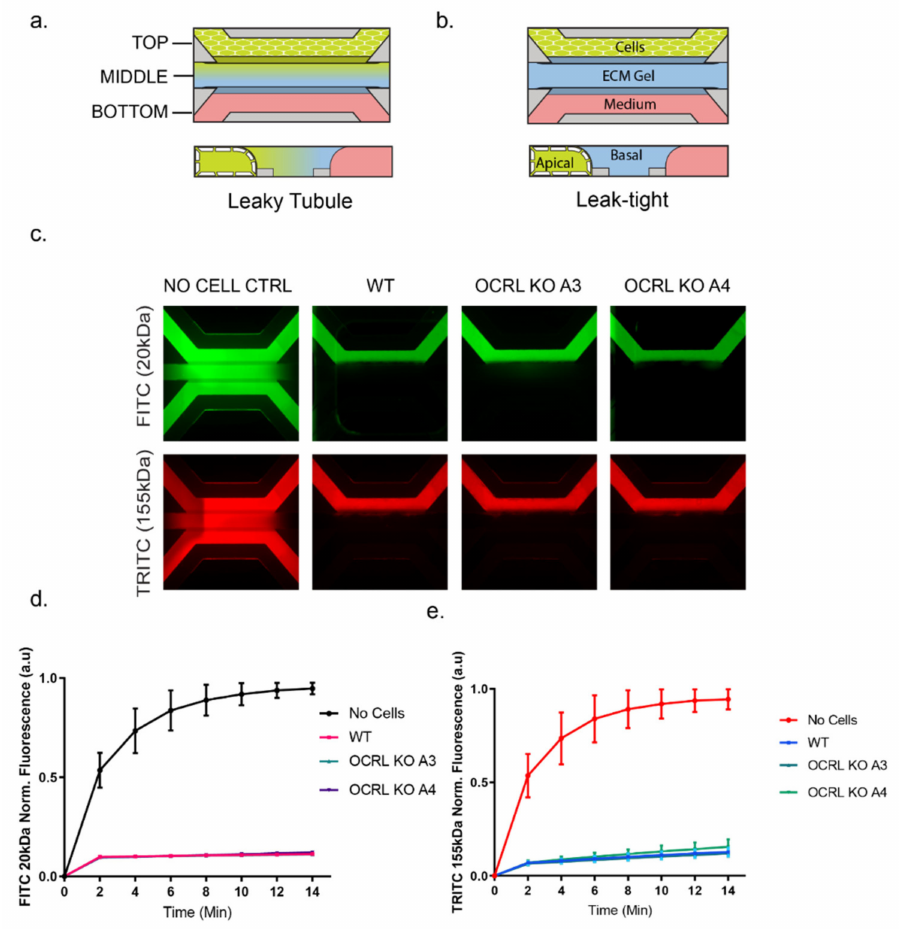
Figure 3. Barrier integrity assay: ( a ) a cartoon of the 3-lane OrganoPlate microfluidic chips with a top perfusion channel with cells, middle gel channel and bottom medium channel. When dye-containing medium was added in the lumen, the dye did not permeate into the gel channel if the tubule was leak tight. ( b ) If the tubule was leaky or in cell-free control chips, the dye diffused into the gel channel. ( c ) Images of the leak-tight tubules of HK-2 cells in WT and OCRL KO clones (A3 and A4) vs. a cell-free control for leakiness for both 20 kDa FITC Dextran and 155 kDa TRITC Dextran molecules. ( d , e ) Graphs showing the curve for the cell-free control chip with the diffusion of the dye and its normalised fluorescence intensity increasing over the duration of the assay (14 min). Leak-tight tubules had stable ratios of signal intensities in the perfusion channel vs. the gel channel. The XY graph was plotted with the mean and SD values, N = 3. Each N had values from at least 5 chips per